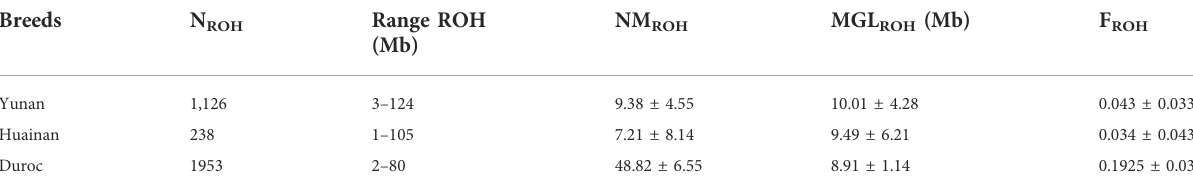
TABLE 2 Genomic distributions and descriptive statistics of ROH in Yunan, Huainan and Duroc. Breeds N ROH